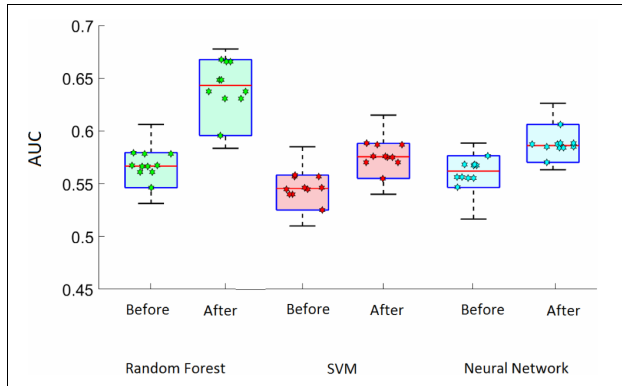
FIGURE 5 | The effect of removing redundant features from the feature set over 10 trials for each model. Markers inside the box plots represent the result of each of the 10 trials. AUC, area under the curve; SVM, support vector machine. Increase in area under the curve indicates higher